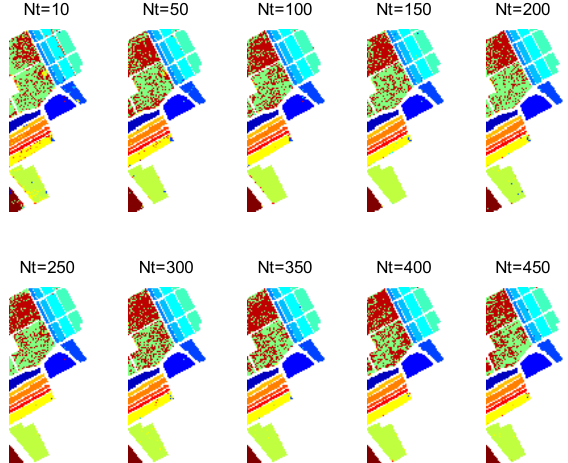
and different (cid:13) for Salinas 4 = 15 3